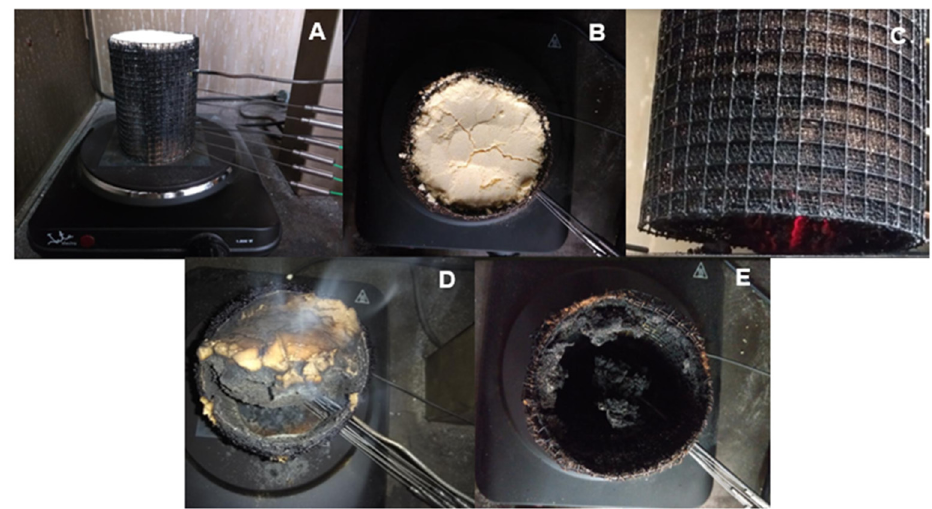
Figure 4. The sequence of images taken during the experiments.